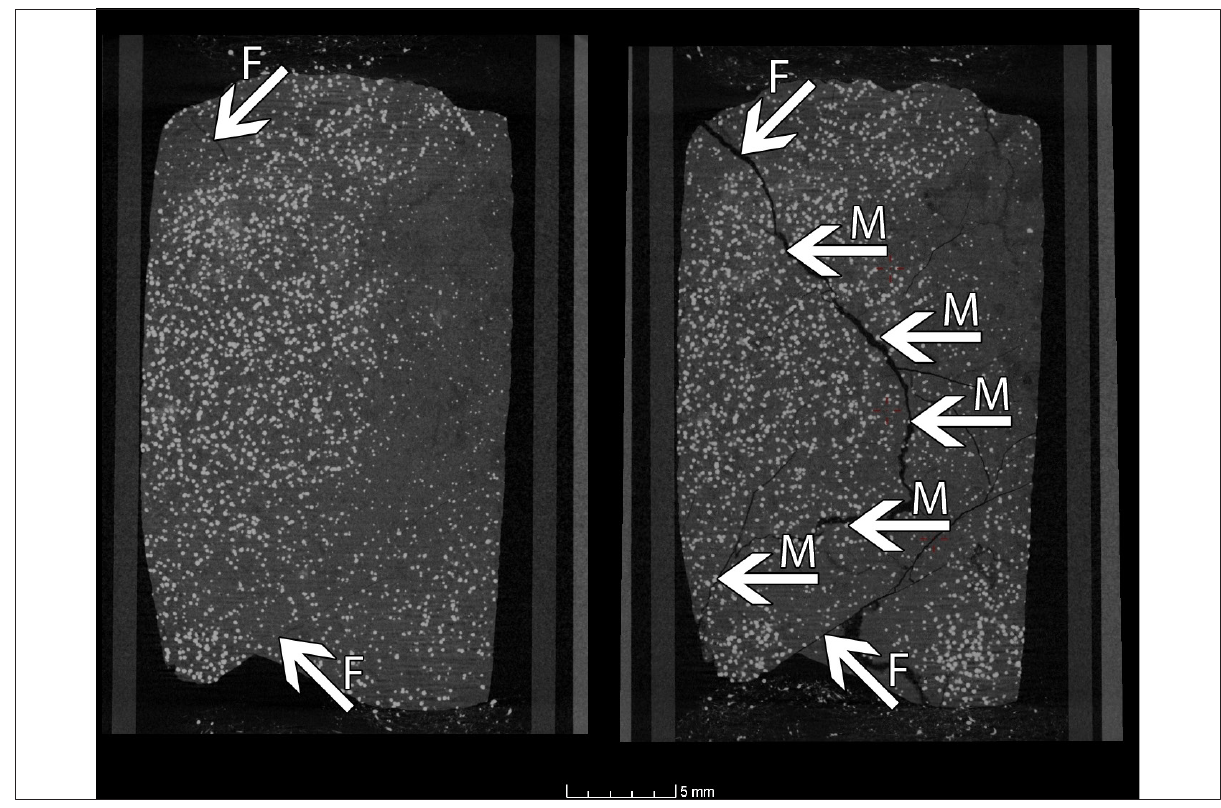
F indicates cleats or cracks that existed in the pre-loaded particles that enlarged during compression; M indicates mineral inclusions that may have had an influence on either crack initiation or crack propagation. Figure 8: Comparison of a particle before (left) and after (right) it was heated to 800 ºC at a rate of 31 ºC/s.